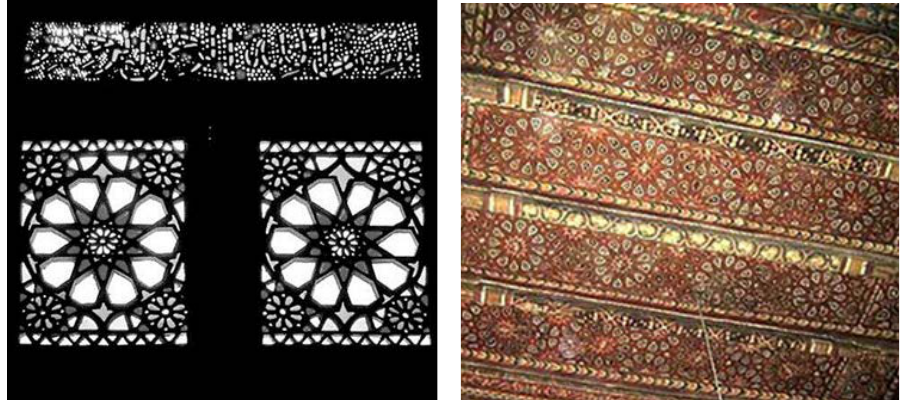
Figure 9-1 wooden dome of Bayt el Suhaymi Figure 9-2 Colored glass dome of Bayt el Suhaymi